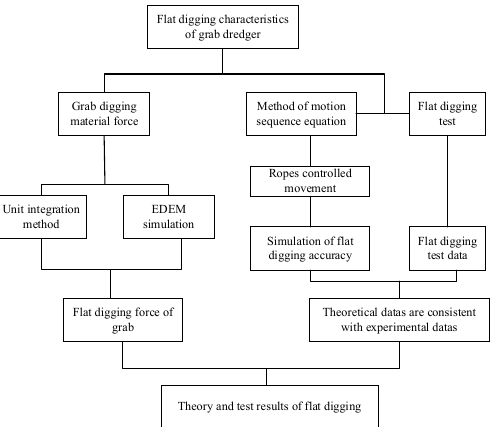
Figure 2. The theoretical and experimental research on the flat digging of grab dredgers.